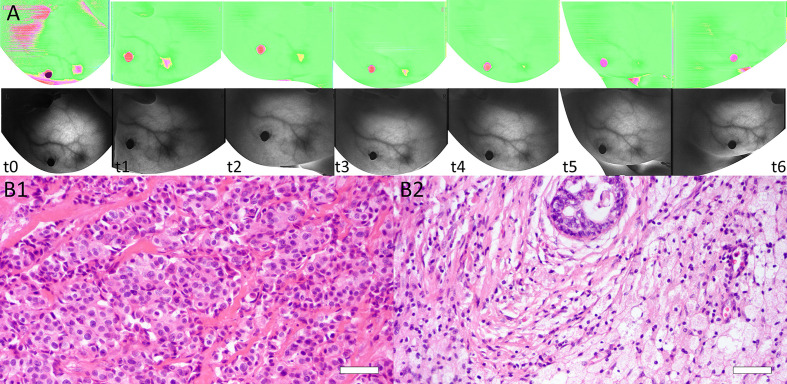

(A) Dynamic BS changes of a lesion at baseline (t0), interim (t1–t5), and before surgery (t6). BS was 1.692 at t0 and decreased after each NACT cycle, with values of 1.510 (t1), 1.322 (t2), 1.307 (t3), 1.289 (t4), and 1.112 (t5). BS was 1.074 before surgery (t6). (B) Images of tissue specimens of the same breast lesion before and after NACT. B1: Before NACT, the tumor had high cellularity (H&E stain ×200, Bar = 50μm). B2: After surgery, the pathologic result was confirmed as a complete response (RCB = 0) (H&E stain ×200, Bar = 50μm).